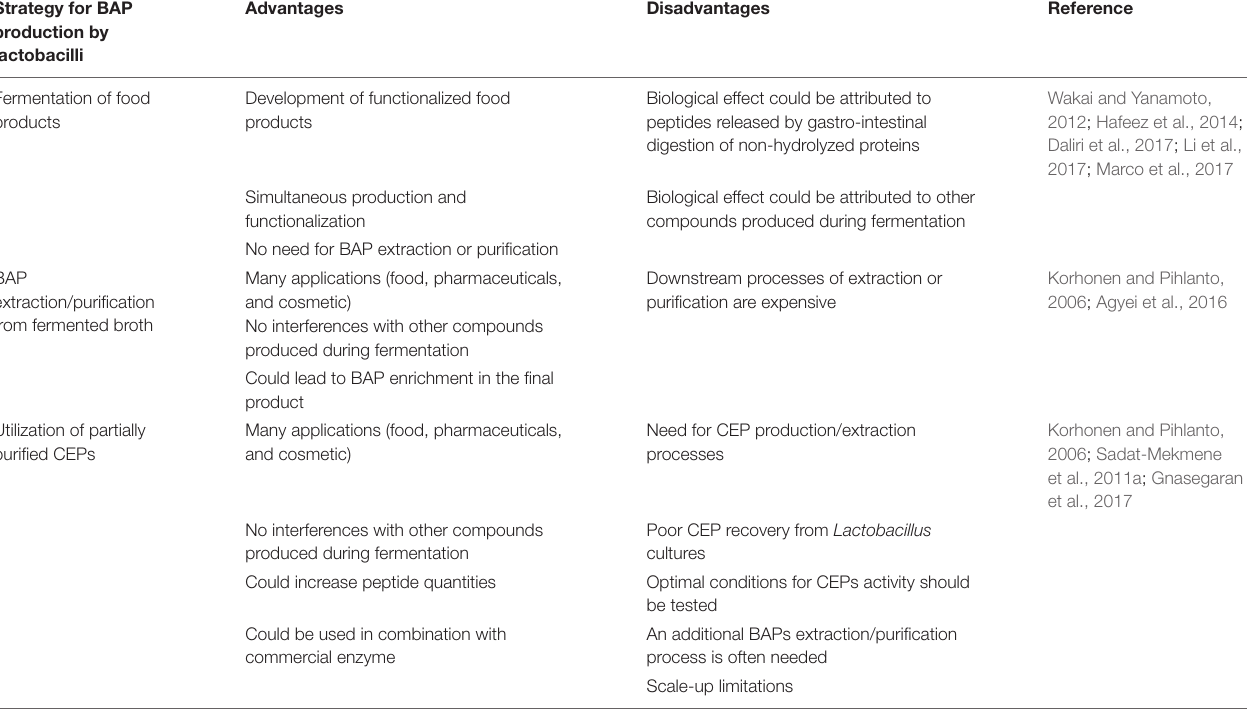
TABLE 1 | Methodologies for BAP production using lactobacilli: advantages and